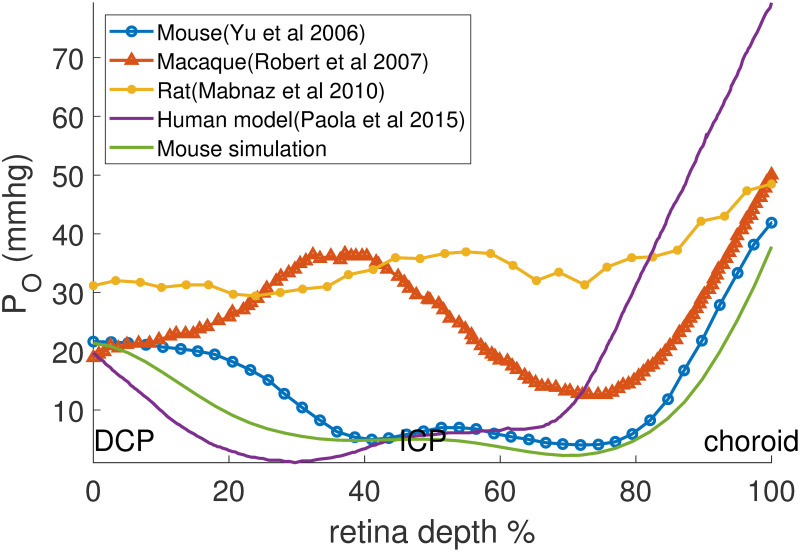
Comparison between retina oxygen partial pressure profiles simulated by our model for the mouse retina and those experimentally measured in mice by [47], in macaques by [41], in rats by [48] and in a human retina model [31].DCP: deep capillary plexi, ICP: intermediate capillary plexi.